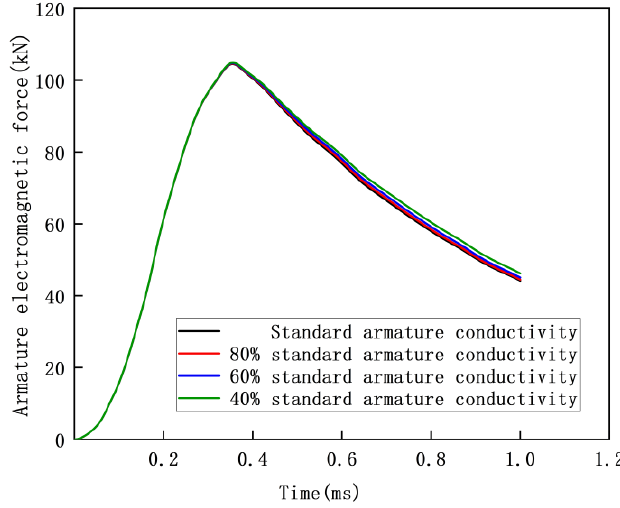
Figure 11. Simulation calculation value of armature electromagnetic force under different armature conductivities in case 1.